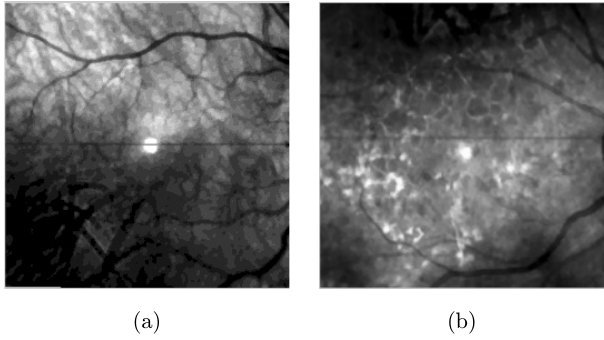
Fig. 9. (a) Extracted normal retinal image, and (b) extracted abnormal retinal